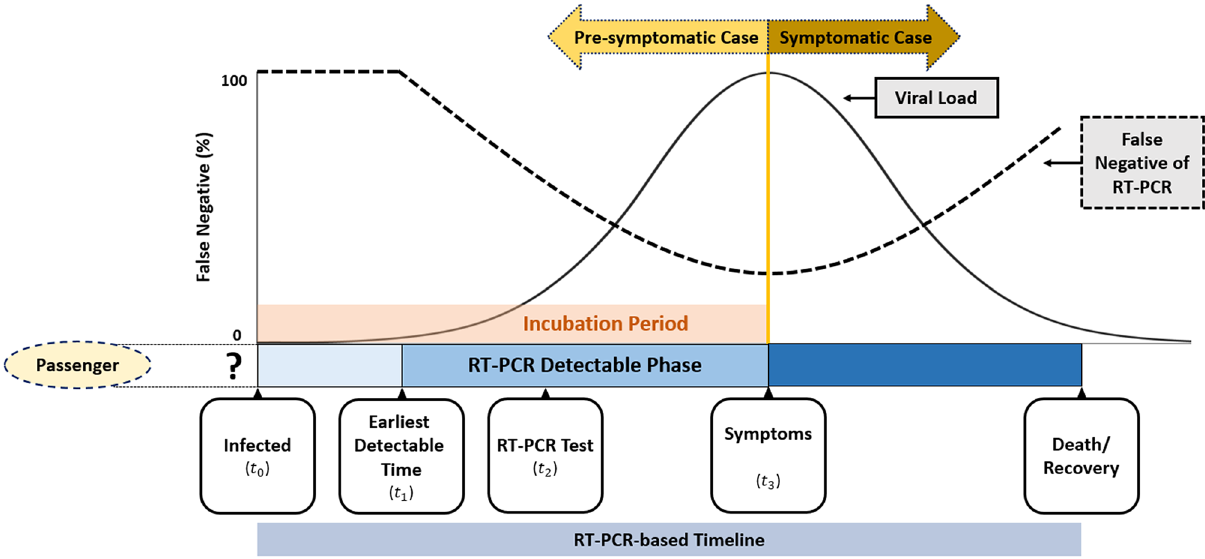
Figure 3. The conceptual diagram for the RT-PCR-based defined disease progression in association with the detectability of the